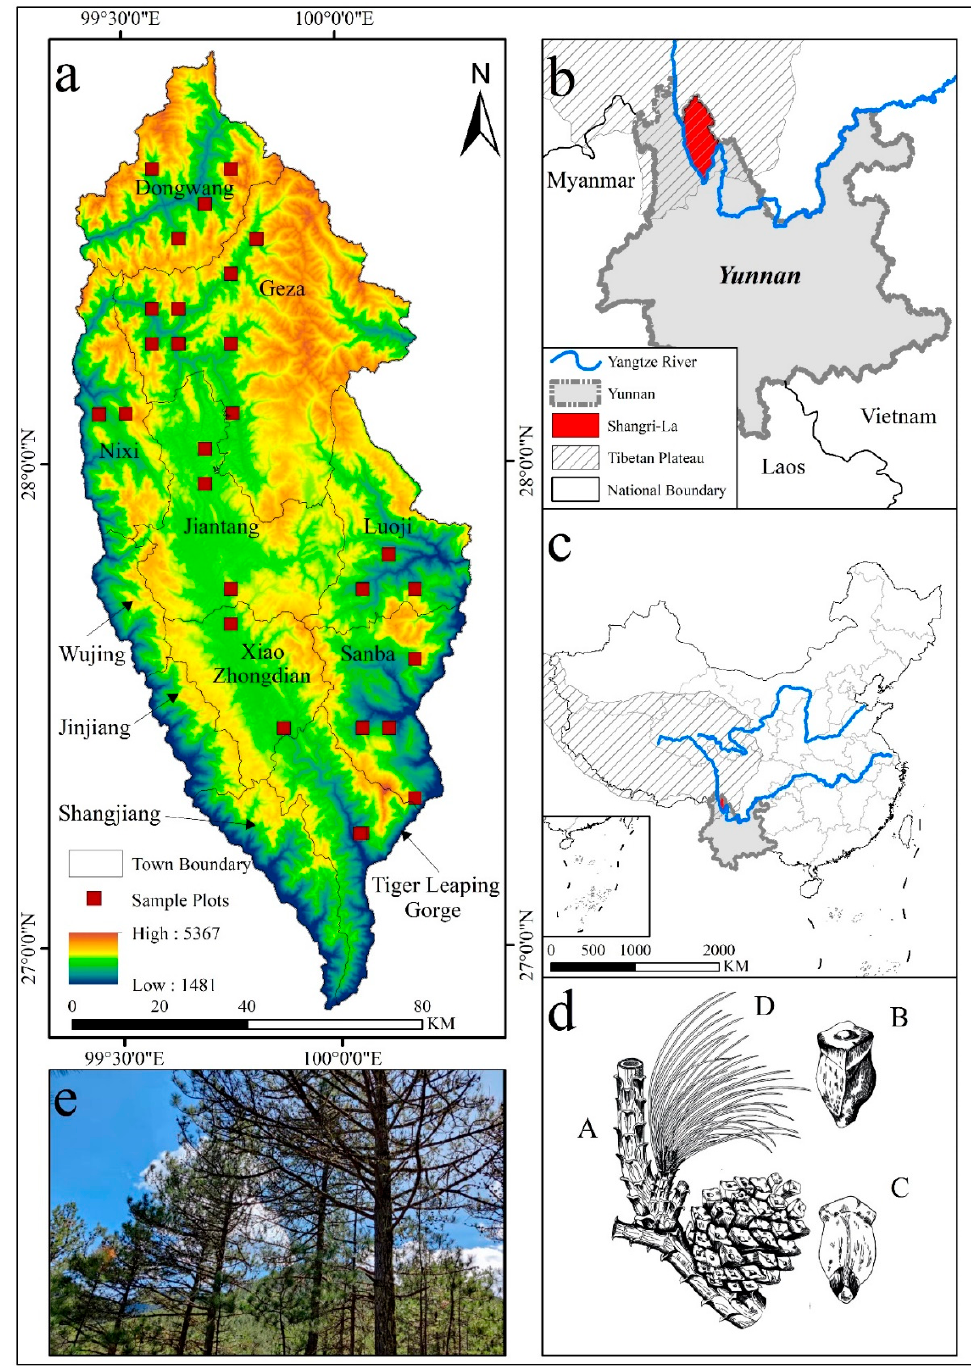
Figure 1. Study area and the distribution of sample plots: ( a ) Distribution of sample plots ( b ) Location of Shangri-La ( c ) Location of Yunnan in China ( d ) Morphological characteristics of Pinus densata , where A represents the Cone-bearing branchlet and seed cone, B represents the seed scale abaxial view, C represents the seed scale adaxial view, and D represents conifer pine needles. ( e ) Photo of Pinus densata in one sample plot.